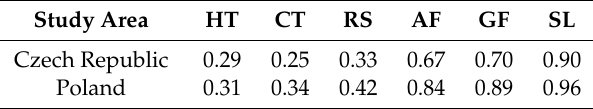
Table 1. Gini coe ffi cients of tourism infrastructure concentration in the Czech and Polish research areas. Note: The coe ffi cients between Poland and the Czech Republic cannot be compared due to di ff erences in the number and area of the research fields clipped to the study area boundaries. Acronyms: HT—Hiking Trails; CT—Cycle Trails; RS—Roads; AF—Accommodation facilities; GF—Gastronomic Facilities; SL—Ski Lifts. Source: author’s own research. Figure 7. Spatial concentration (Lorenz curves) of tourism infrastructure in the Czech ( left ) and Polish ( right ) research areas. Note: The curves between Poland and Czech Republic cannot be compared due to differences in the number and area of the research fields clipped to the study area boundaries. Acronyms: HT—Hiking Trails; CT—Cycle Trails; RS—Roads; AF—Accommodation Facilities; GF—Gastronomic Facilities; SL—Ski Lifts. Source: authors’ own research.